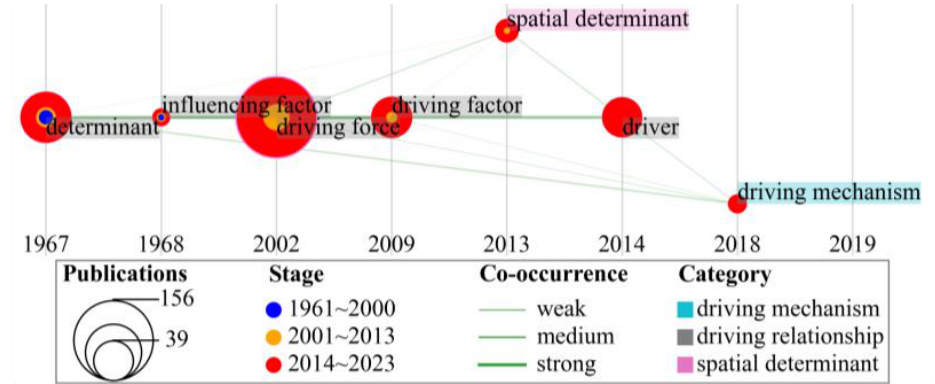
Figure 7. Development of themes indicating “driving analysis”.